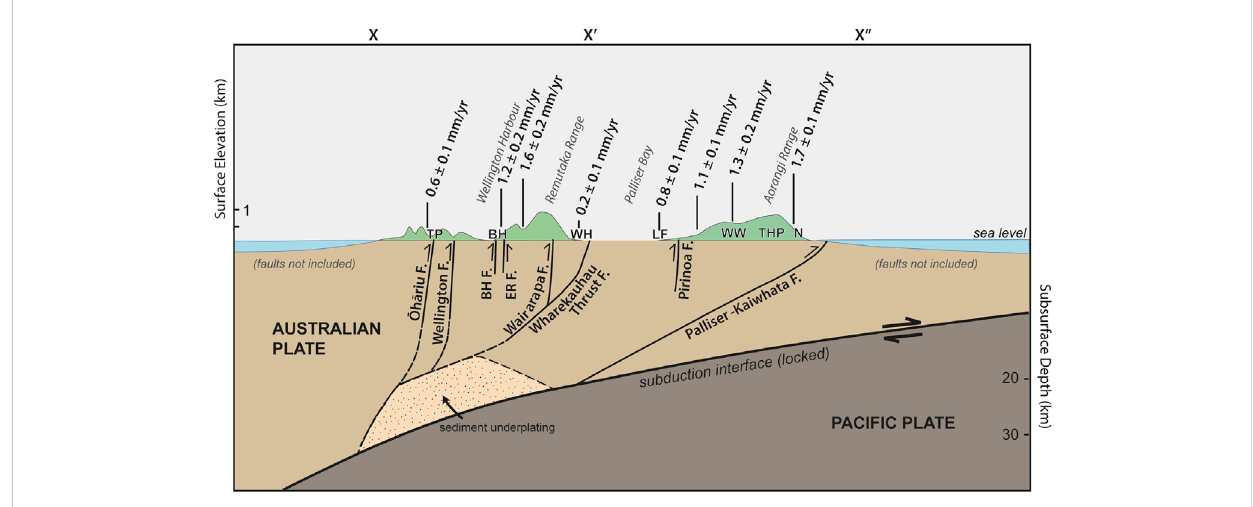
FIGURE 9 Schematic cross Section X-X ′ -X ’’ (see Figure 2 for location of pro fi le) across the Wellington south coast, showing representative topography (vertically exaggerated), calculated uplift rates and locations of major faults and those observed to offset the late Pleistocene marine terraces; “ BH F ” is Baring Head Fault, “ ER F ” is East River Fault. Locations from west to east: TP, Tongue Point; BH, Baring Head; WH, Wharekauhau; LF, Lake Ferry; WW, Washpool/Whatarangi; THP, Te Humenga Point; N, Ngawi. Figure modi fi ed after Little et al. (2009) and updated using subsurface data from Begg and Johnston (2000), Henrys et al. (2013), Williams et al. (2013) and this